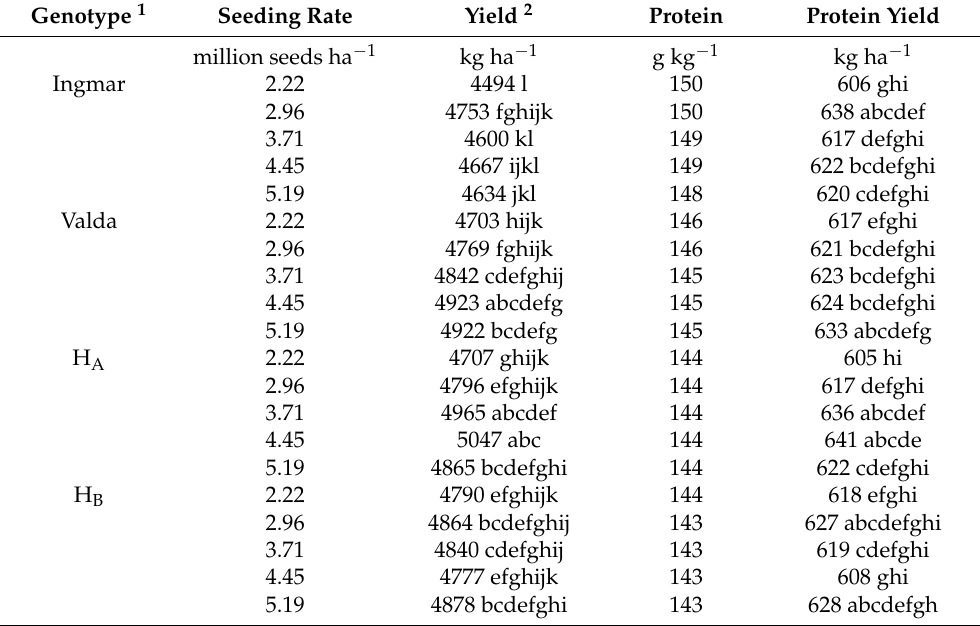
Table 6. Means for the genotype by seeding rate interaction for yield, protein, and protein yield combined across seven, eight, and eight environments (location-year) in North Dakota,